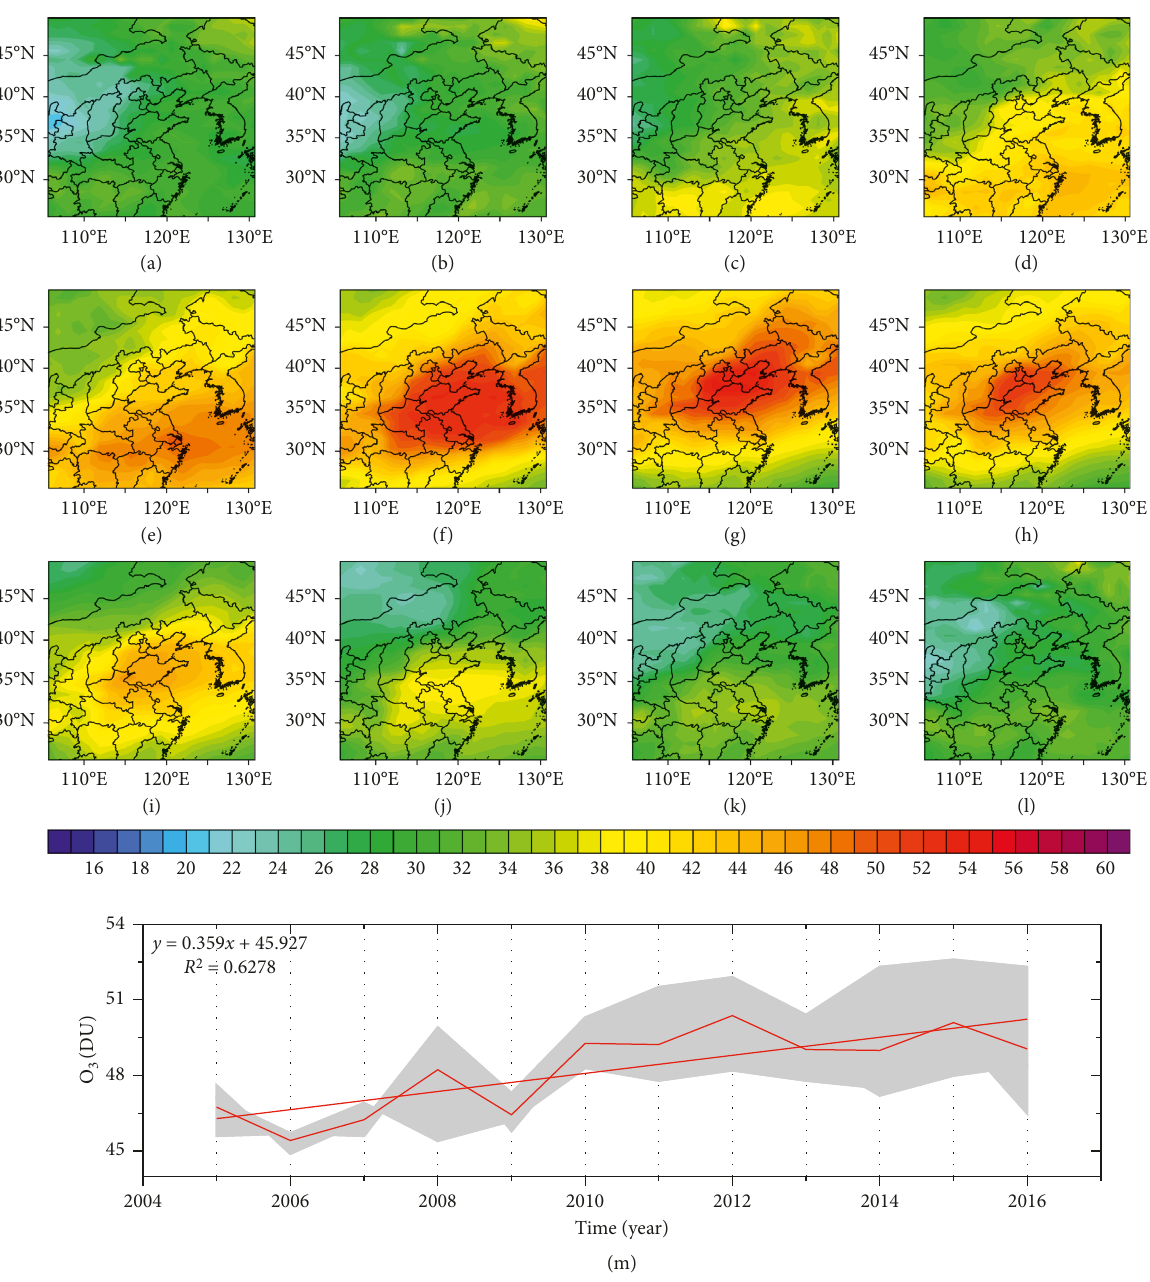
Figure 2: Monthly average tropospheric O 3 vertical column density (VCD) (units: DU) during 2005–2016: (a) January; (b) February; (c) March; (d) April; (e) May; (f) June; (g) July; (h) August; (i) September; (j) October; (k) November; (l) December; (m) summer time O 3 series in the NCP, indicated as the area in the outer box in Figure 1. The gray shaded area indicates the variation range because the annual summer data cover 3 months (June to August), and the red line is the summer average of the